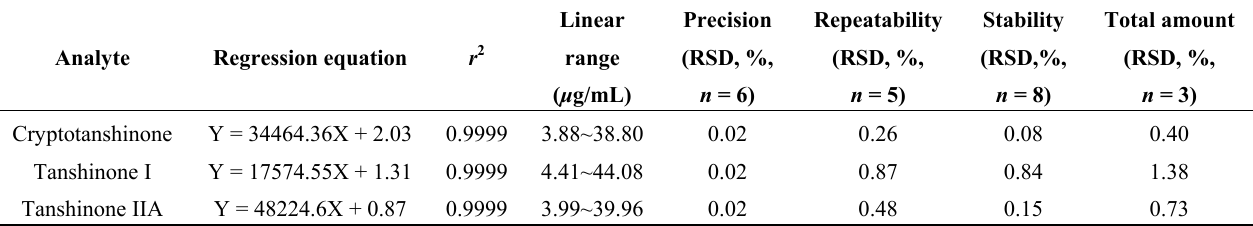
Table 3. Regression, precision, repeatability and stability of the three compounds in the S. miltiorrhiza Bunge reference extractive.